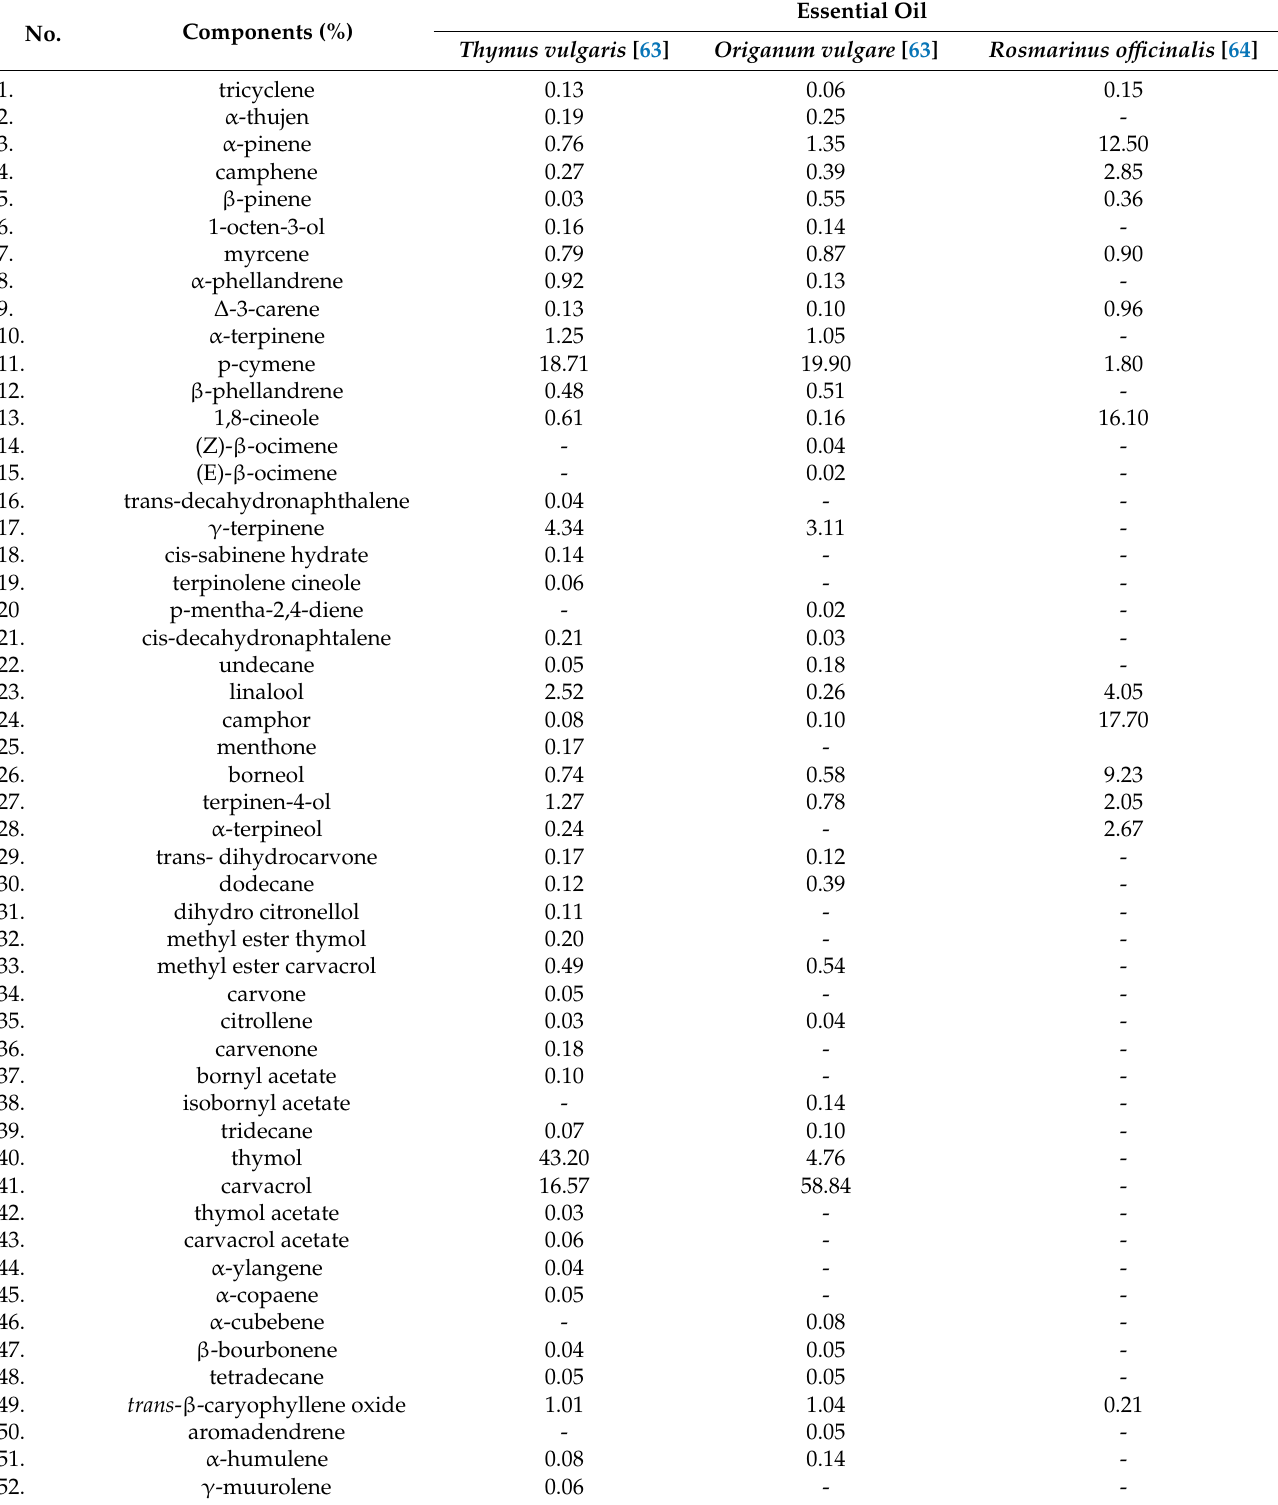
Table 1. Chemical composition of Thymus vulgaris (thyme), Origanum vulgare (oregano), and Rosmari- nus officinalis (rosemary) essential